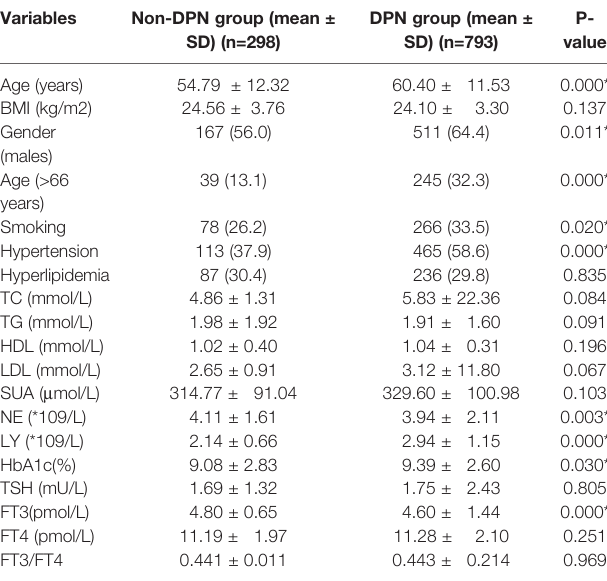
TABLE 1 | Comparison of general information and biochemical indicators between non-DPN group and DPN group. Variables